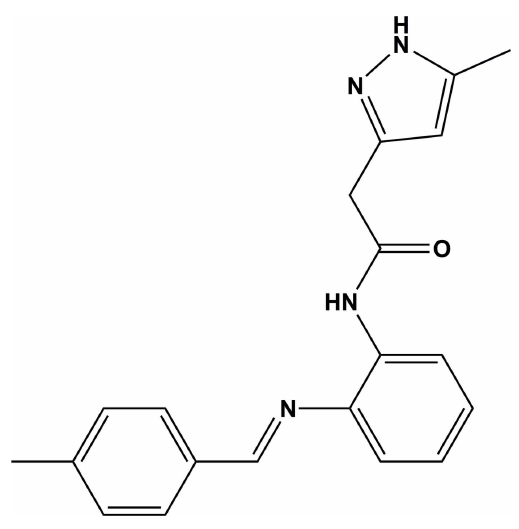
Table 1 Hydrogen-bond geometry (A˚ , (cid:3)